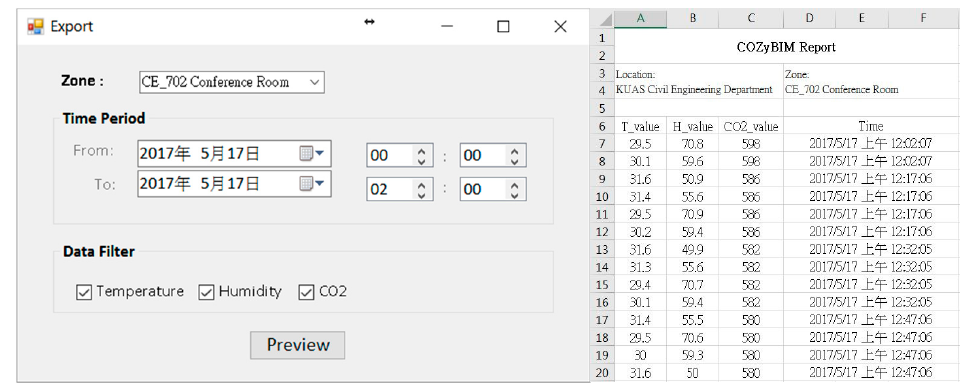
Figure 10. Data exported to the excel format file function.